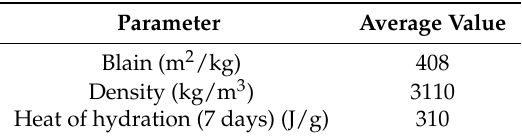
Table 3. Basic physical and mechanical properties of Cement CEM I 42.5 R (Mokrá cement plant) according to EN 196-6 [42] and EN 196-8 [43].